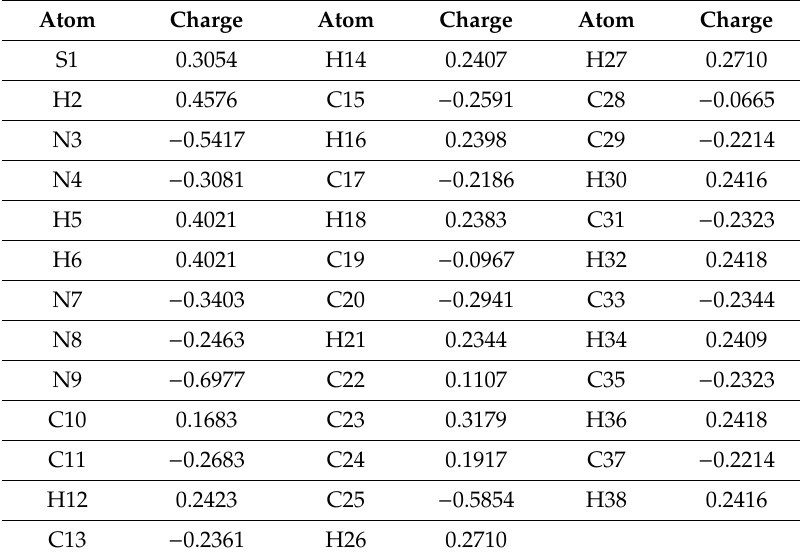
Table 4. Natural atomic charges of 2 a .